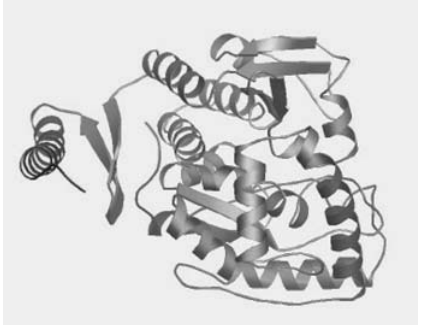
Fig.4. Predicted tertiary structure of catalytic domain in the PvtH proteins by swissModel First